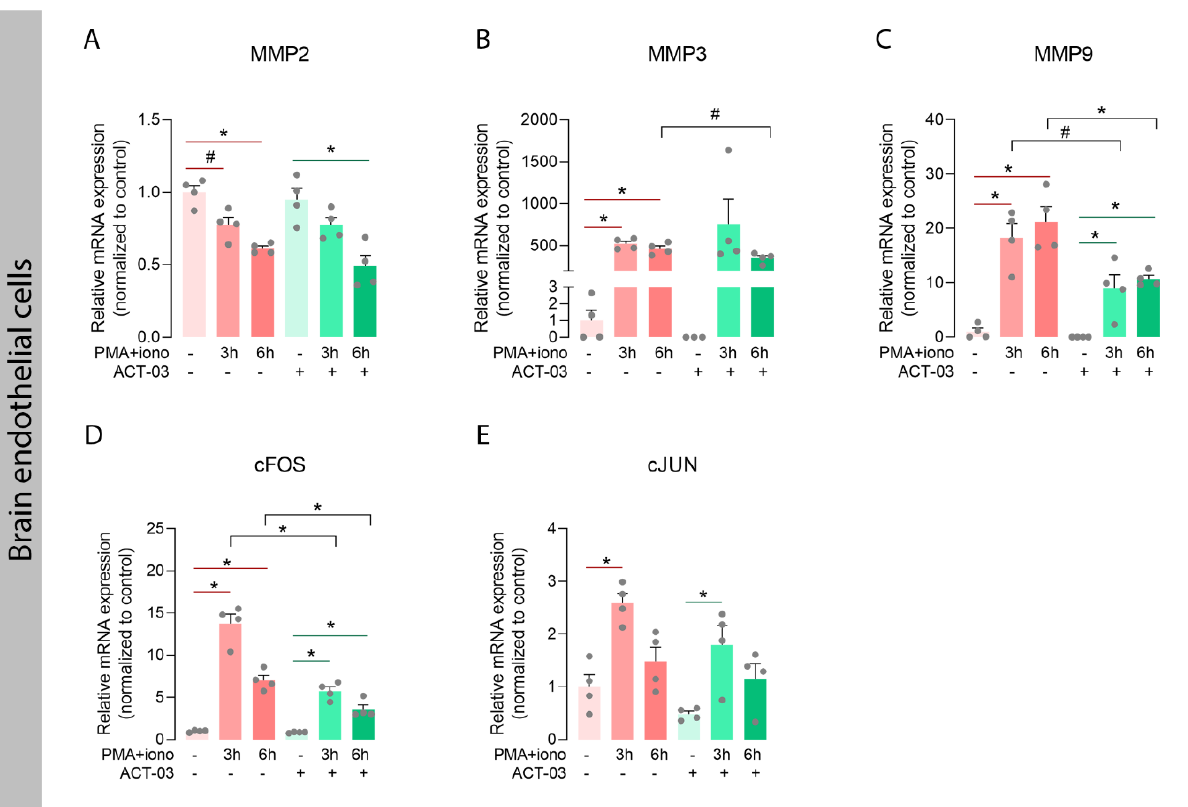
Figure 7. Attenuation of metalloproteinases and inflammatory transcription factors by ACT-03 in brain endothelial cells. ( A – E ) In the human brain endothelial cell line hCMEC/D3 ( n = 4), PMA + iono stimulation resulted in less MMP2 expression and higher expression of MMP3, MMP9, cFOS, and cJUN ( p < 0.05). Upon ACT-03 treatment, less cFOS expression was observed compared to stimulation only ( p < 0.05), as well as a trend towards less MMP3 and MMP9 expression ( p = 0.0571, p < 0.05). Bar graphs display mean + SEM, with individual values as dots; #, p = 0.0571; *, p < 0.05. Within treatment comparisons indicated with red/green lines. Between treatment comparisons indicated with hooked black lines.